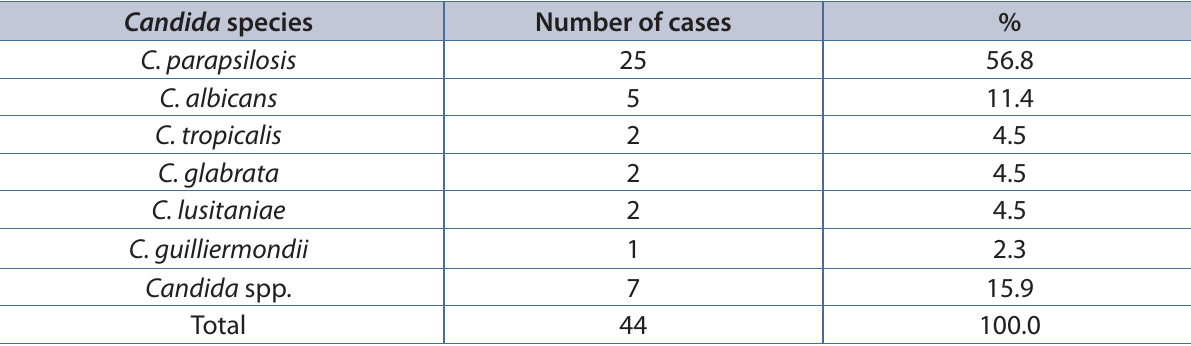
Table 2. Candida species in patients under one year of age admitted to Botucatu Medical School